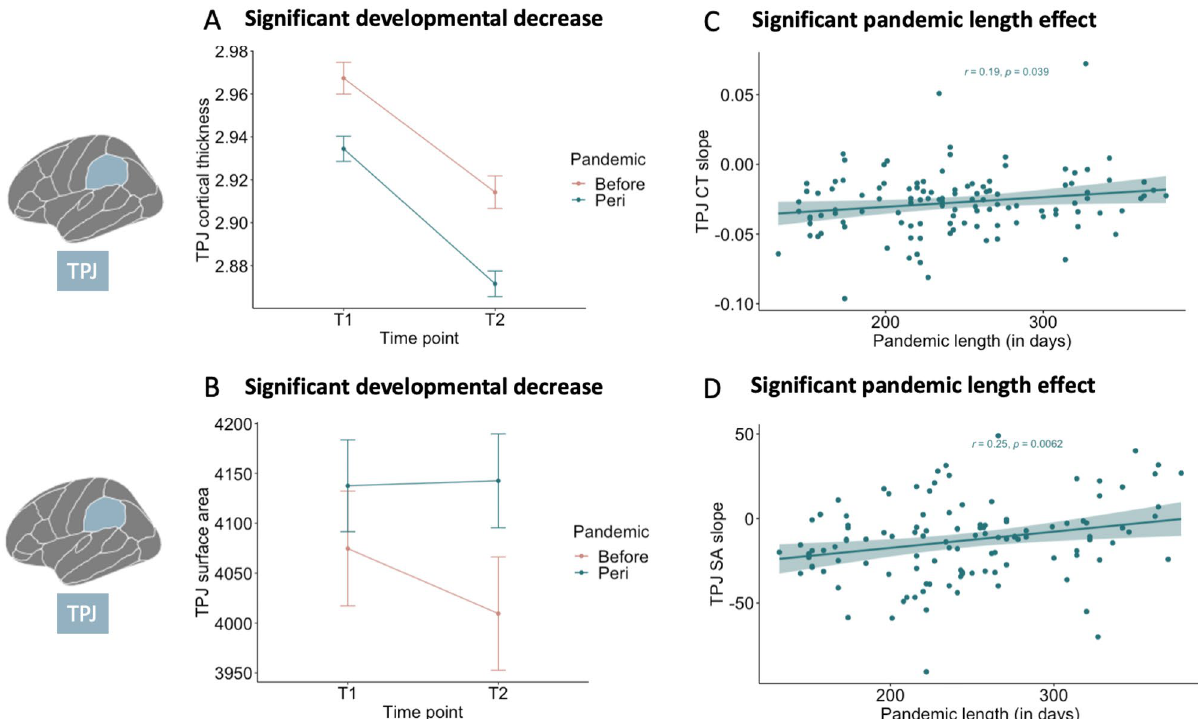
Figure 4. Visualizations of the linear mixed model results of TPJ thickness and surface area development. In ( A ) TPJ cortical thickness is presented on the y-axis and time point on the x-axis, showing a significant developmental decrease independent of pandemic group. In ( B ) TPJ surface area is presented on the y-axis and time point on the x-axis, showing a significant developmental decrease independent of pandemic group. In ( C ) slopes of TPJ cortical thickness of participants in the peri -pandemic group are presented on the y-axis and pandemic length (in days) on the x-axis, showing a positive association. In ( D ) slopes of mPFC surface area of participants in the peri -pandemic group are presented on the y-axis and pandemic length (in days) on the x-axis, showing a positive association. TPJ temporoparietal junction; CT cortical thickness, SA surface Results indicated that TPJ surface area significantly decreased between the two time points ( F (1, 187) = 57.13, p < 0.001), where relatively higher TPJ surface area was observed at time point 1 ( M = 4104 mm, SE = 41.6, 95% CI [4022, 4186]) compared to time point 2 ( M = 4072 mm, SE = 41.6, 95% CI [3990, 4154]). No interaction effect was observed between time point and pandemic group ( F (1, 187) = 0.01, p = 0.94). Furthermore, a main effect of sex was observed ( F (1, 149) = 33.13, p < 0.001), where boys showed relatively higher TPJ surface area ( M = 4314 mm, SE = 58.1, 95% CI [4200, 4429]) compared to girls ( M = 3861 mm, SE = 56.9, 95% CI [3749, 3974]), but sex did not interact with timepoint of pandemic group ( F (1, 187) = 0.60, p = 0.44). See Fig. 4B for the for the significant negative slopes (i.e., developmental decrease) of TPJ surface area independent of pandemic effects. 95% CI [4258, 4372]) compared to time point 2 ( M = 4416 mm, SE = 28.8, 95% CI [4359, 4473]). Additionally, we observed an interaction effect between time point and pandemic group ( F (1, 190) = 6.21, p corrected < 0.04), where